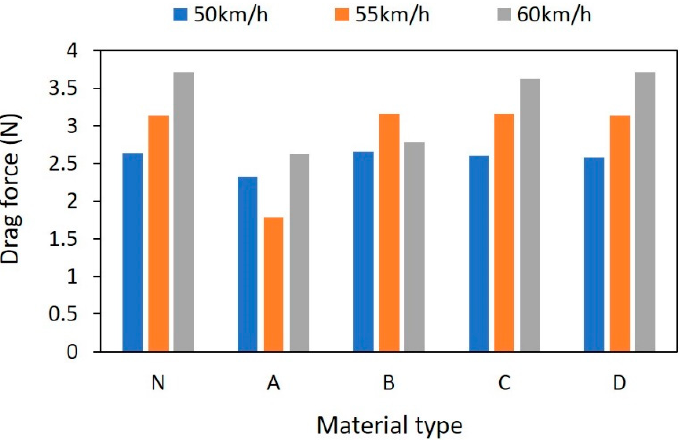
Figure 8. Comparison of drag forces of each fabric obtained from the cylinder test (N represents the drag force when the model was no fabric).